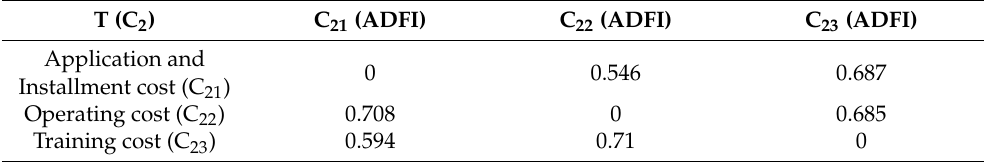
Table 7. Average direct fuzzy influence matrix T between Economical (C 2 ) sub-criterions.